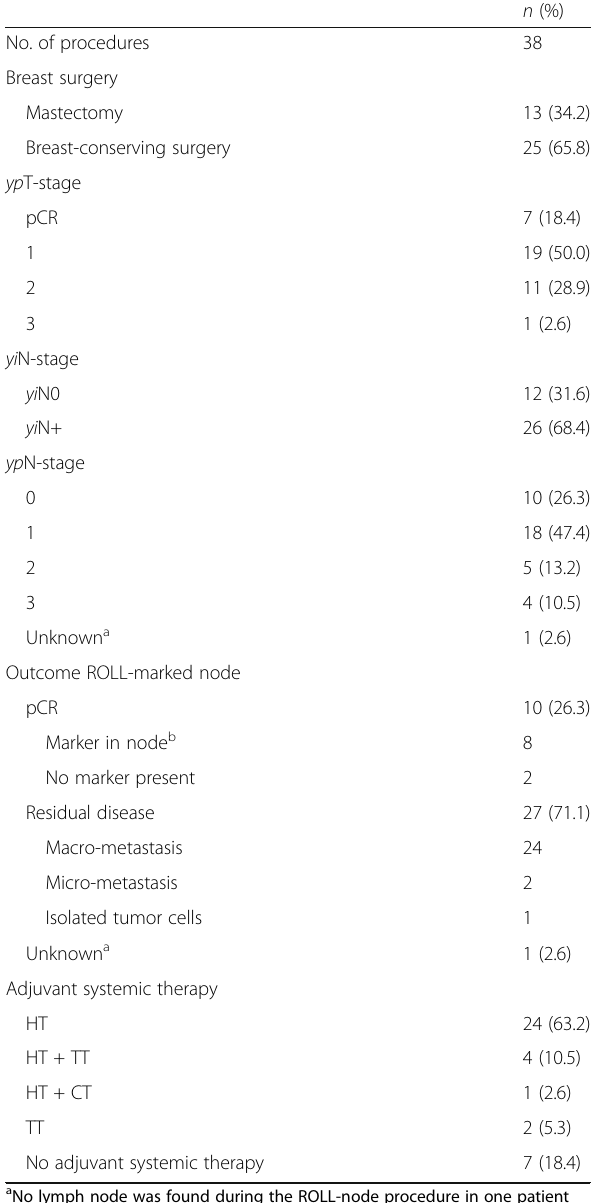
Table 2 Surgery, pathological response, and adjuvant systemic